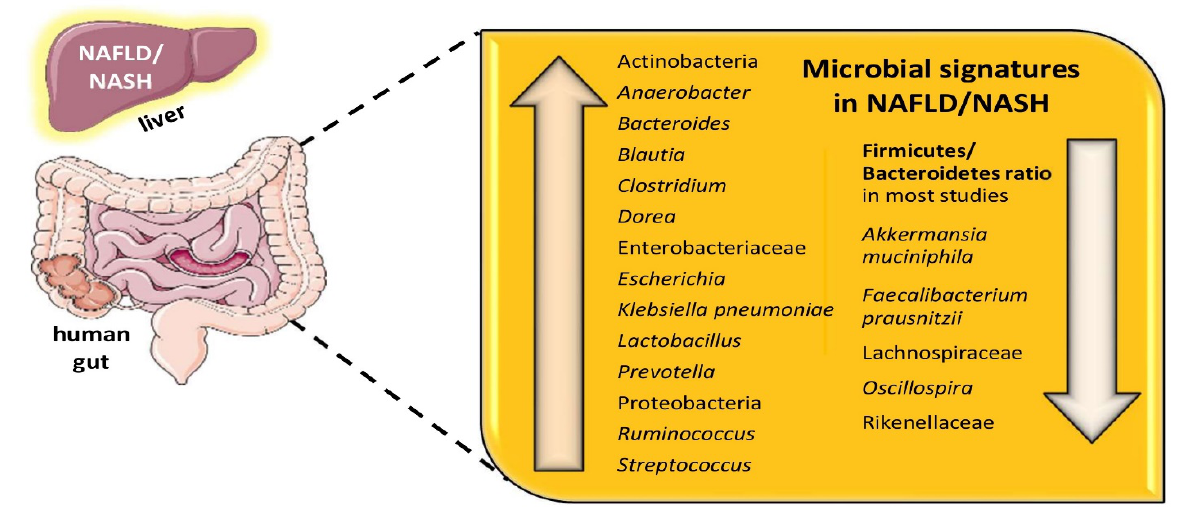
Figure 2. Gut microbial signatures found in NAFLD/NASH. Abbreviations: NAFLD, Non-Alcoholic Fatty Liver Disease; NASH, Non-Alcoholic Steatohepatitis. (All images are originated from the free medical website http://smart.servier.com/ by Servier licensed under a Creative Commons Attribu- tion 3.0 Unported License, Accessed on 1 October 2021).